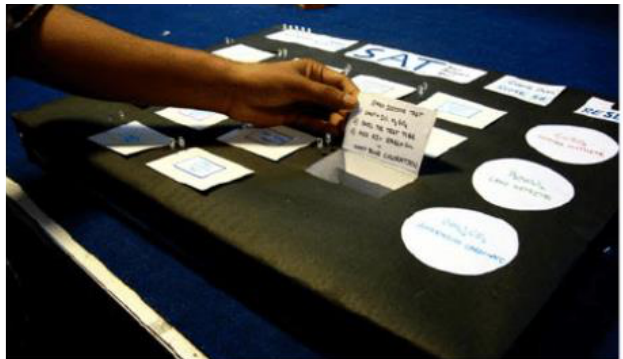
Figure 3. Formation of acute angle [16].